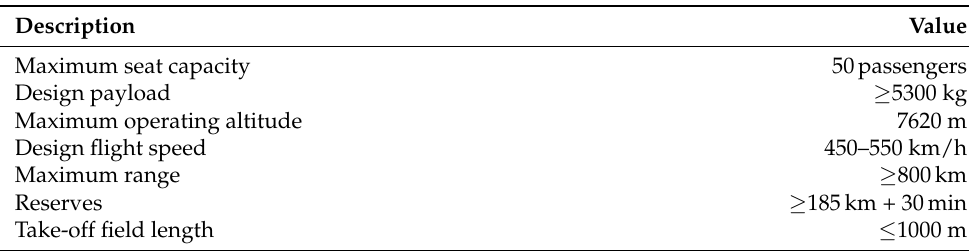
Table 1. Top-level aircraft requirements for the hybrid-electric regional aircraft development planned in F UT P R I NT 50.